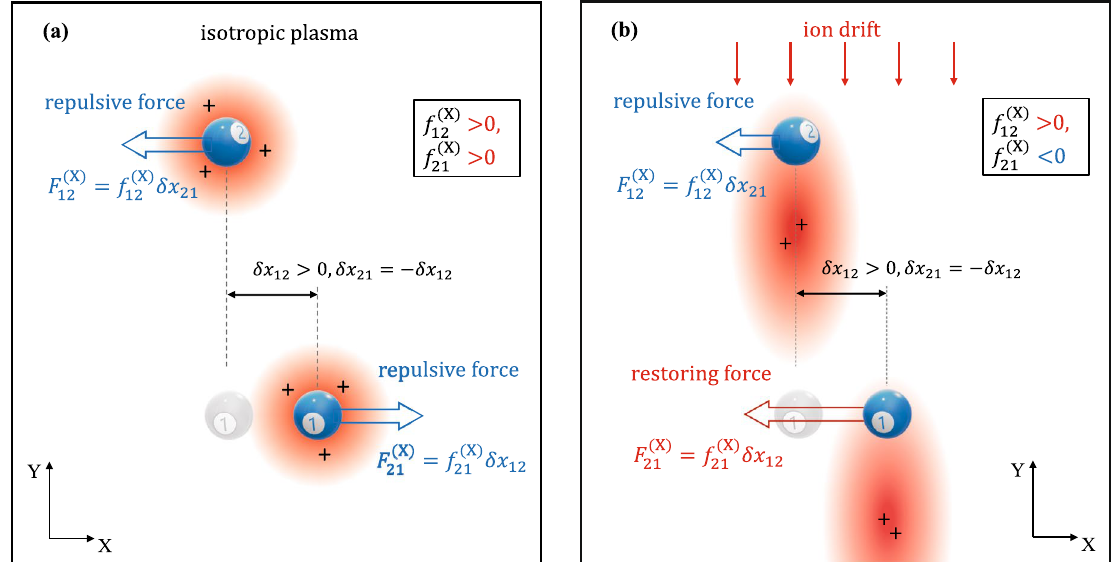
Figure 7. Forces acting horizontally between particles in an isotropic plasma ( a ) and when a field is applied ( b ) and the nonreciprocity is rather